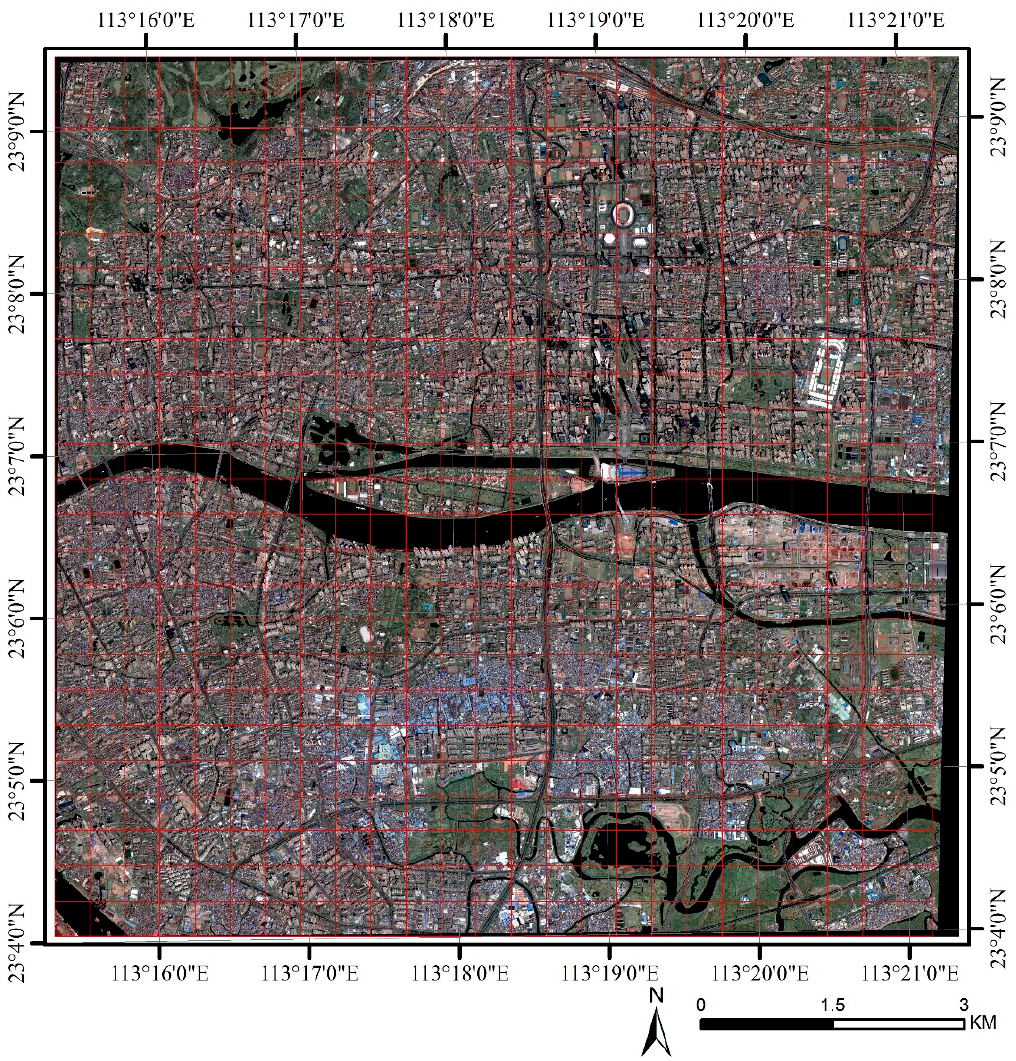
Figure 1. The visible image map with red grids of 400 m × 400 m for the central urbanized area of Guangzhou. This image was obtained by the GeoEye-1 satellite on 22 October 2017.